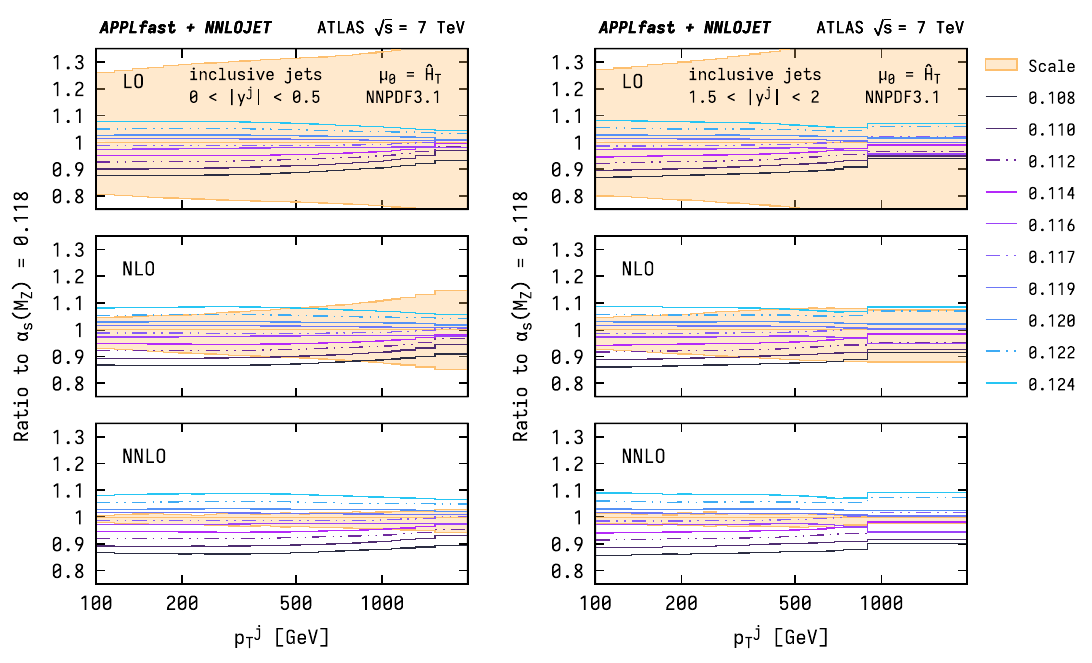
Fig. 3 LO, NLO, and NNLO predictions for the ATLAS 7TeV inclu- rapidityandfordifferentvaluesof α s ( M Z ) .Thepredictionsareobtained with α s -dependent variants of the NNPDF3.1 PDF set. The shaded area sivejetcrosssectionasafunctionof p jet fortworepresentativerangesin T indicates the scale uncertainty at the given perturbative order